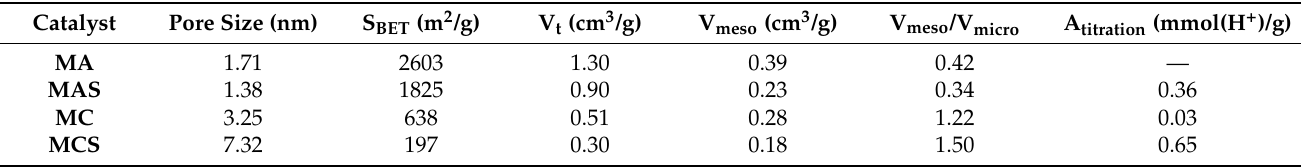
Table 1. Physicochemical properties of various MIL-101